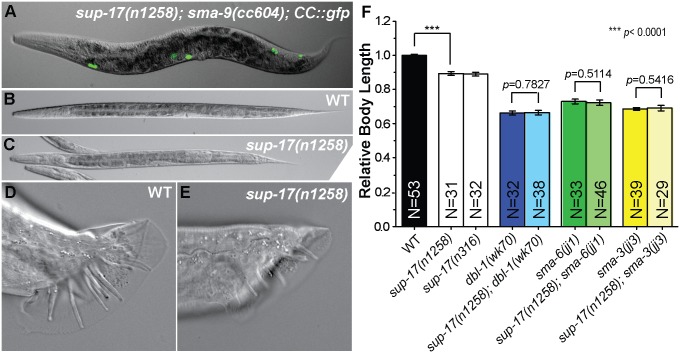
sup-17 functions in Sma/Mab signaling.(A) Merged GFP and DIC image of a sup-17(n1258); sma-9(cc604) animal carrying the CC::gfp reporter. (B-E) Representative DIC images of developmental stage-matched WT (B, D) and sup-17(n1258) (C, E) worms, showing the smaller body size (C) and abnormal male tail (E) of sup-17(n1258) worms. (F) Relative body length of stage-matched WT and various mutant worms measured at the L4 stage. Worms have developed to the L4 stage at 25°C from synchronized L1 stage. The mean body length of WT worms is normalized to 1.0. Error bars represent 95% confidence intervals (CI) for the normalized body length.